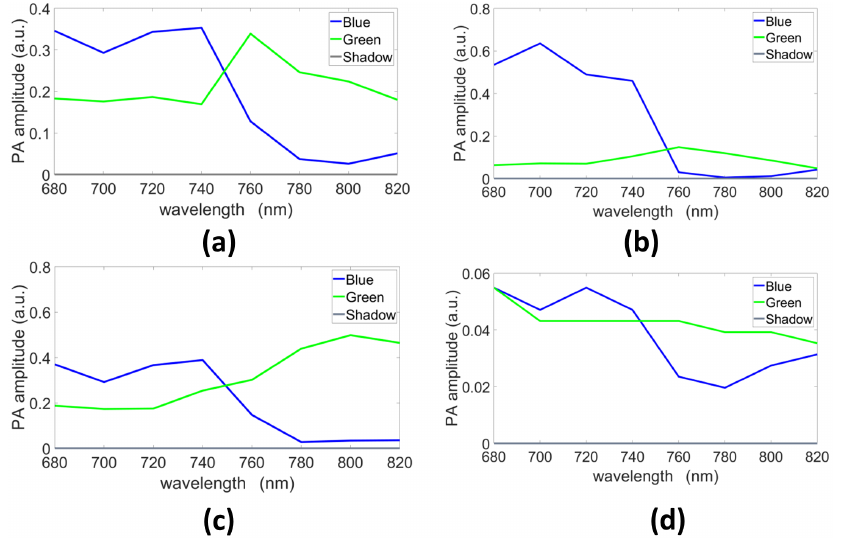
Figure 7. Endmembers estimated with ( a ) GLUP, ( b ) VCA, ( c ) N-FINDR, and ( d ) SSM-S (a.u., arbitrary units).